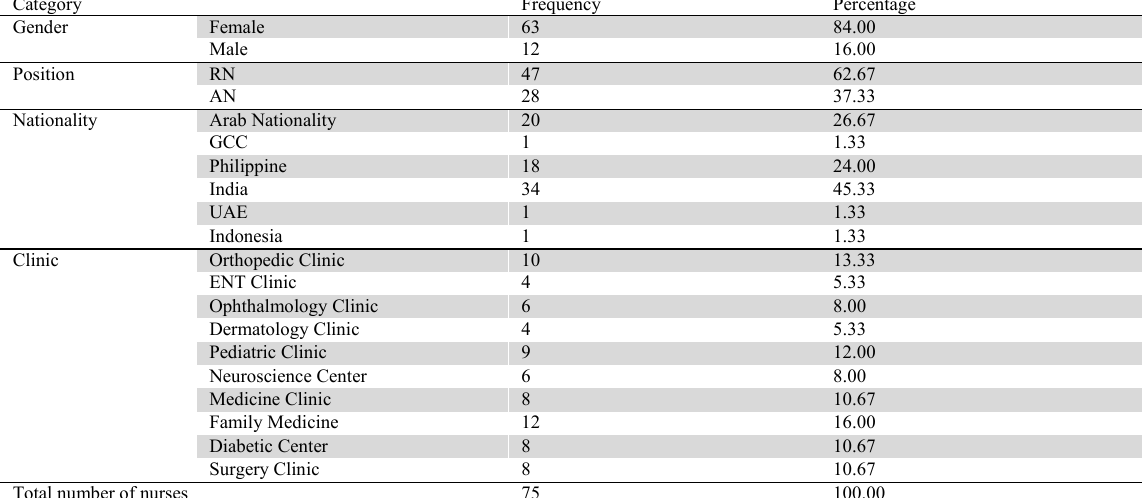
Background information about the outpatient nurses